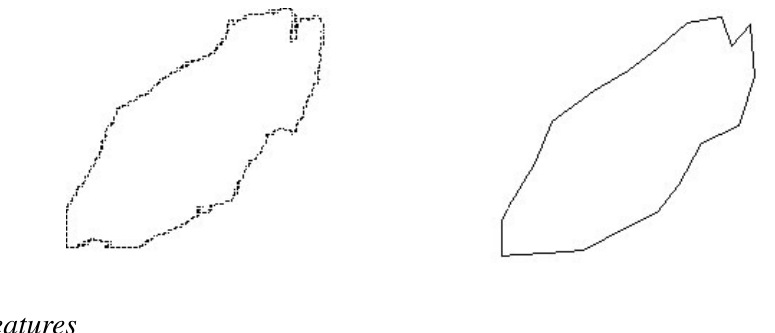
Figure 4. The polygonal fitting of edge of the tobacco leaf. The left image is the original tobacco leaf edge, the right image is the polygonal fitted